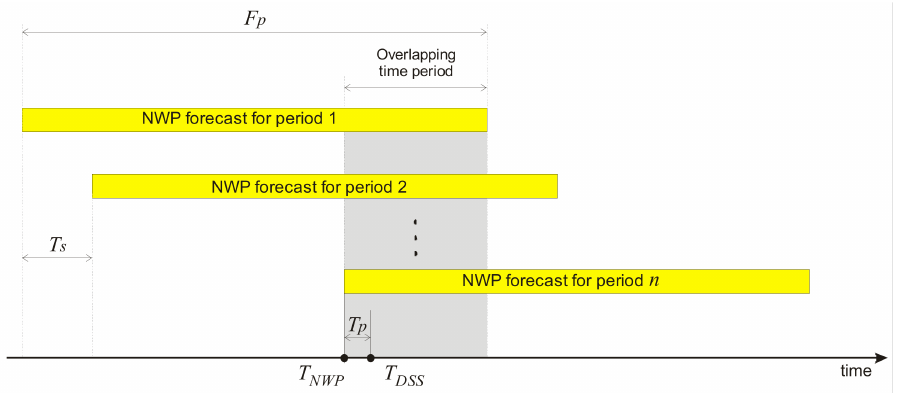
Figure 1. A group of successive